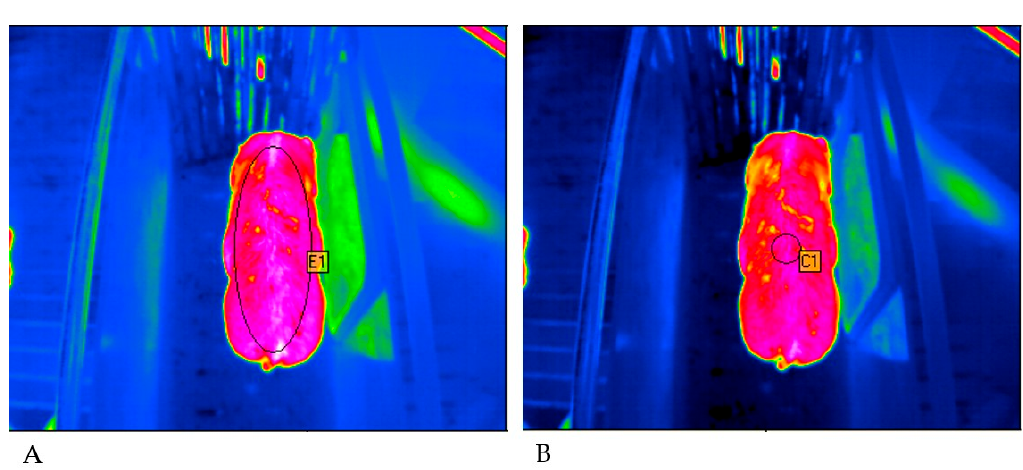
Figure 2. Comparison of the two evaluation methods. ( A ) First method (ME, maximal ellipse) with an elliptical measurement spot placed over the maximum possible area of the pig’s body. ( B ) Second method (SC, standardized circle) with a standard circular measurement spot at the height of the last rib of the animal. (©Alfert).